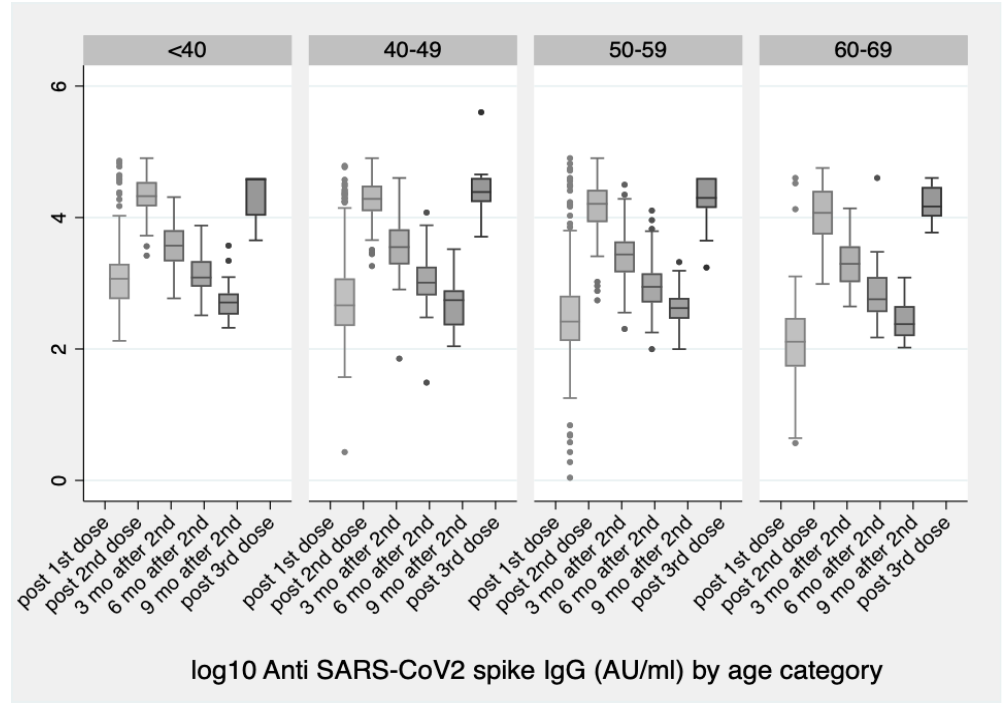
Figure 1. log10 Anti SARS-CoV-2 Spike IgG antibody levels by age group at six selected time points over the course of the vaccination plan: up to three-six-nine months after its completion and one month after the 3rd dose. No significant difference between age groups was found after the third dose ( p = 0.1).